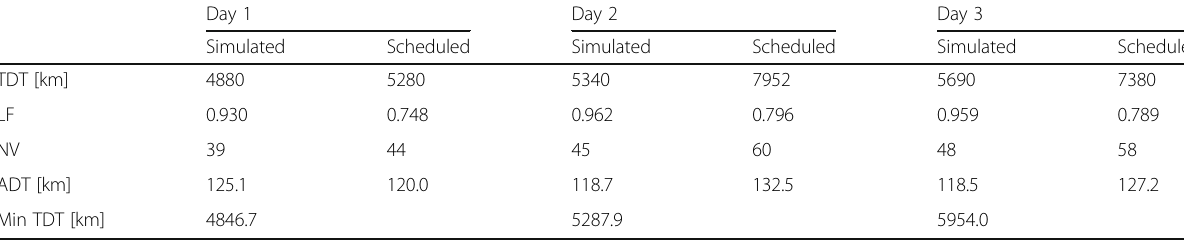
Table 2 Aggregated results of simulations for the analysed days Day 1 Day 2 Day 3 Simulated Scheduled Simulated Scheduled Simulated Scheduled 4880